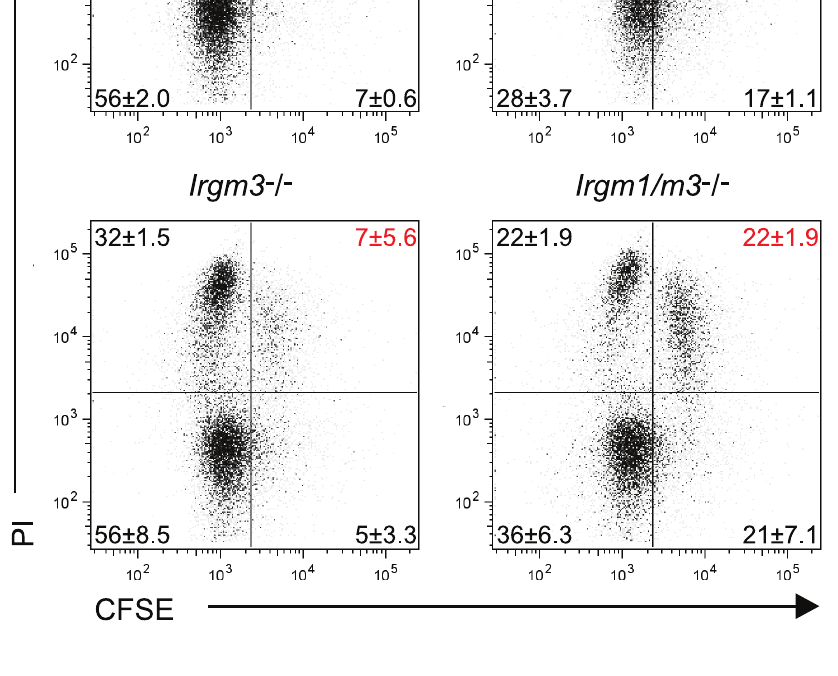
control mice of the same genotype, confirming that the adaptive immune response contributes to immune clearance at later times in the course of the infection (Fig. 7). Depletion of CD4 + T cells, however, had a greater effect on bacterial burden in Irgm1/m3 (-/-)